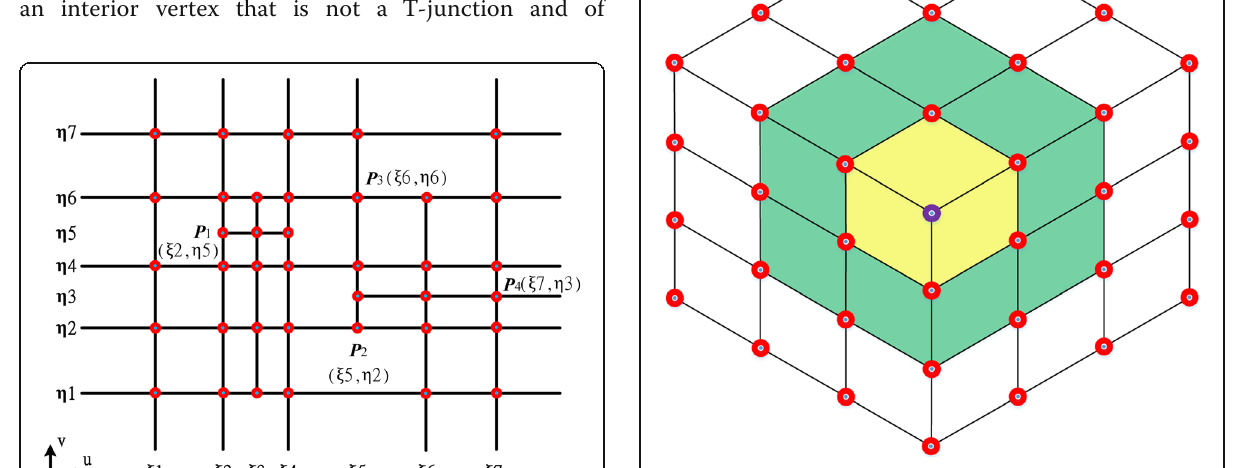
Fig. 5 The T-mesh around the extraordinary point denoted by purple in Fig.